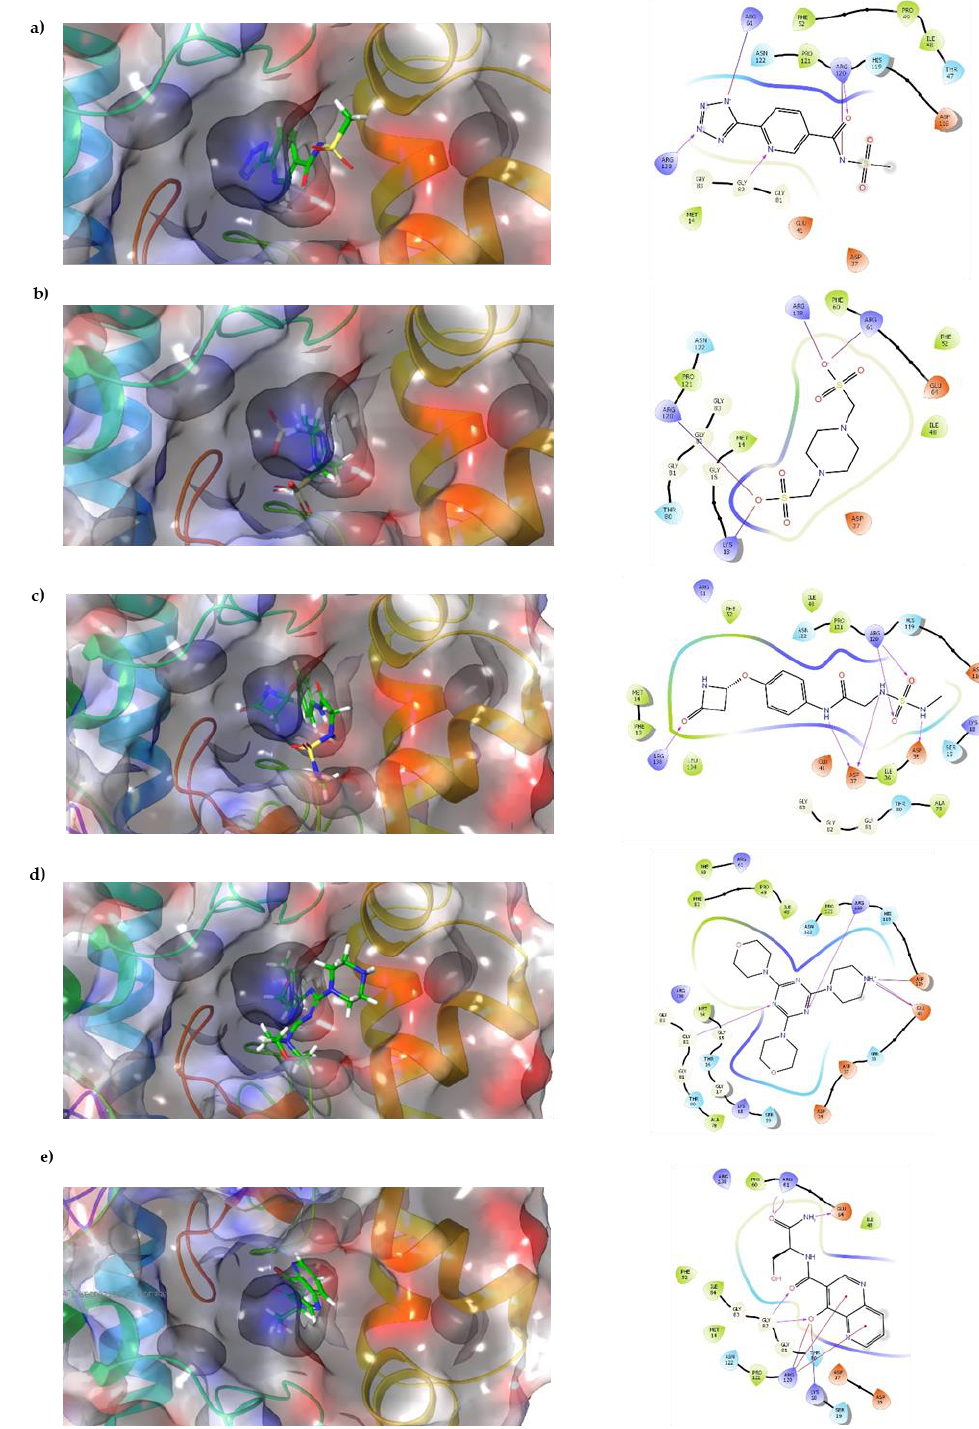
Figure 2. Interaction of top compounds. Two-dimensional representation of SaSK residues interacting with ( a ) C1, ( b ) C2, ( c ) C3, ( d ) C4, and ( e ) C5. Hydrogen bonds are depicted in pink, salt bridges are shown in red-blue, and Pi-cation interactions in